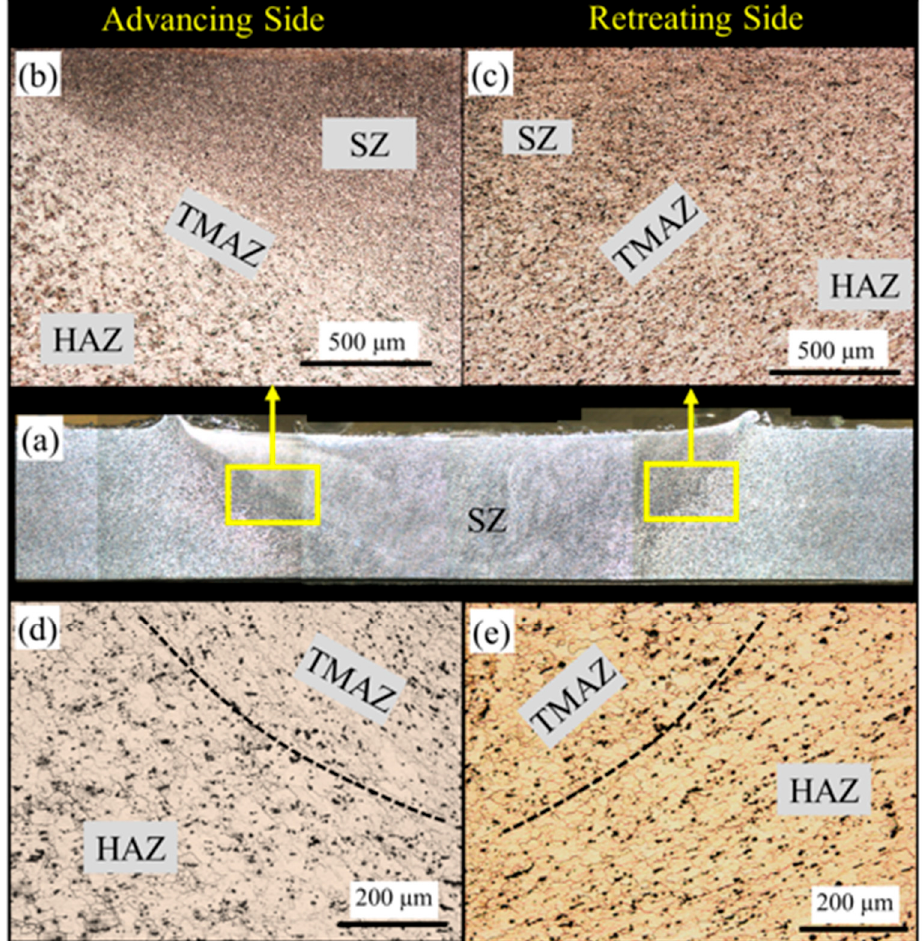
Figure 4. Microstructure of similar joints of Al6061(T6) at Sample C-1: ( a ) cross section view; ( b , c ) low-magnification advancing side (AS) and retreating side (RS), respectively; and ( d , e ) high-magnification views of ( b , c ), respectively.